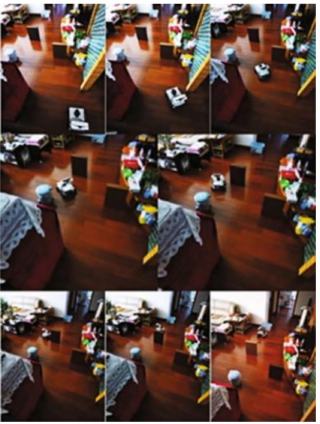
Figure 1. Path map of intelligent